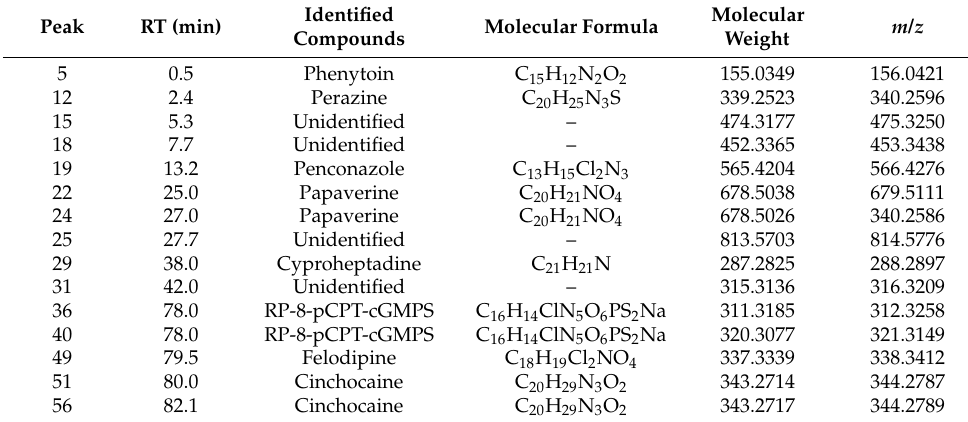
Figure 4. LC-MS/MS chromatogram of D. sublaevigata . Table 8. The compounds identified in D. sublaevigata . Table 8. The compounds identified in D. sublaevigata .